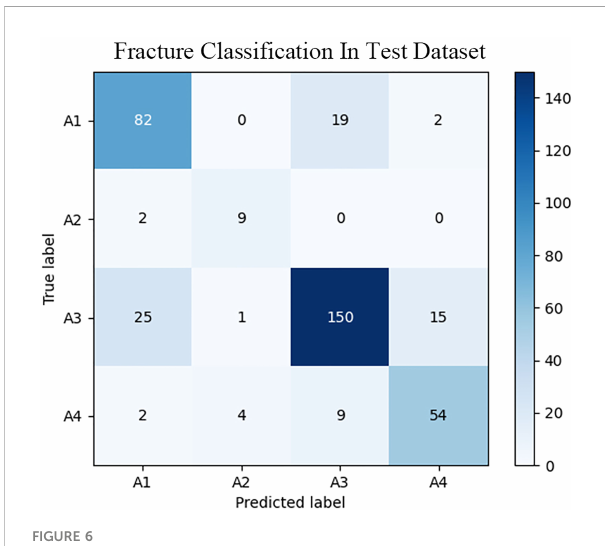
FIGURE 6 Confusion matrix of the fracture classi fi cation system in the test